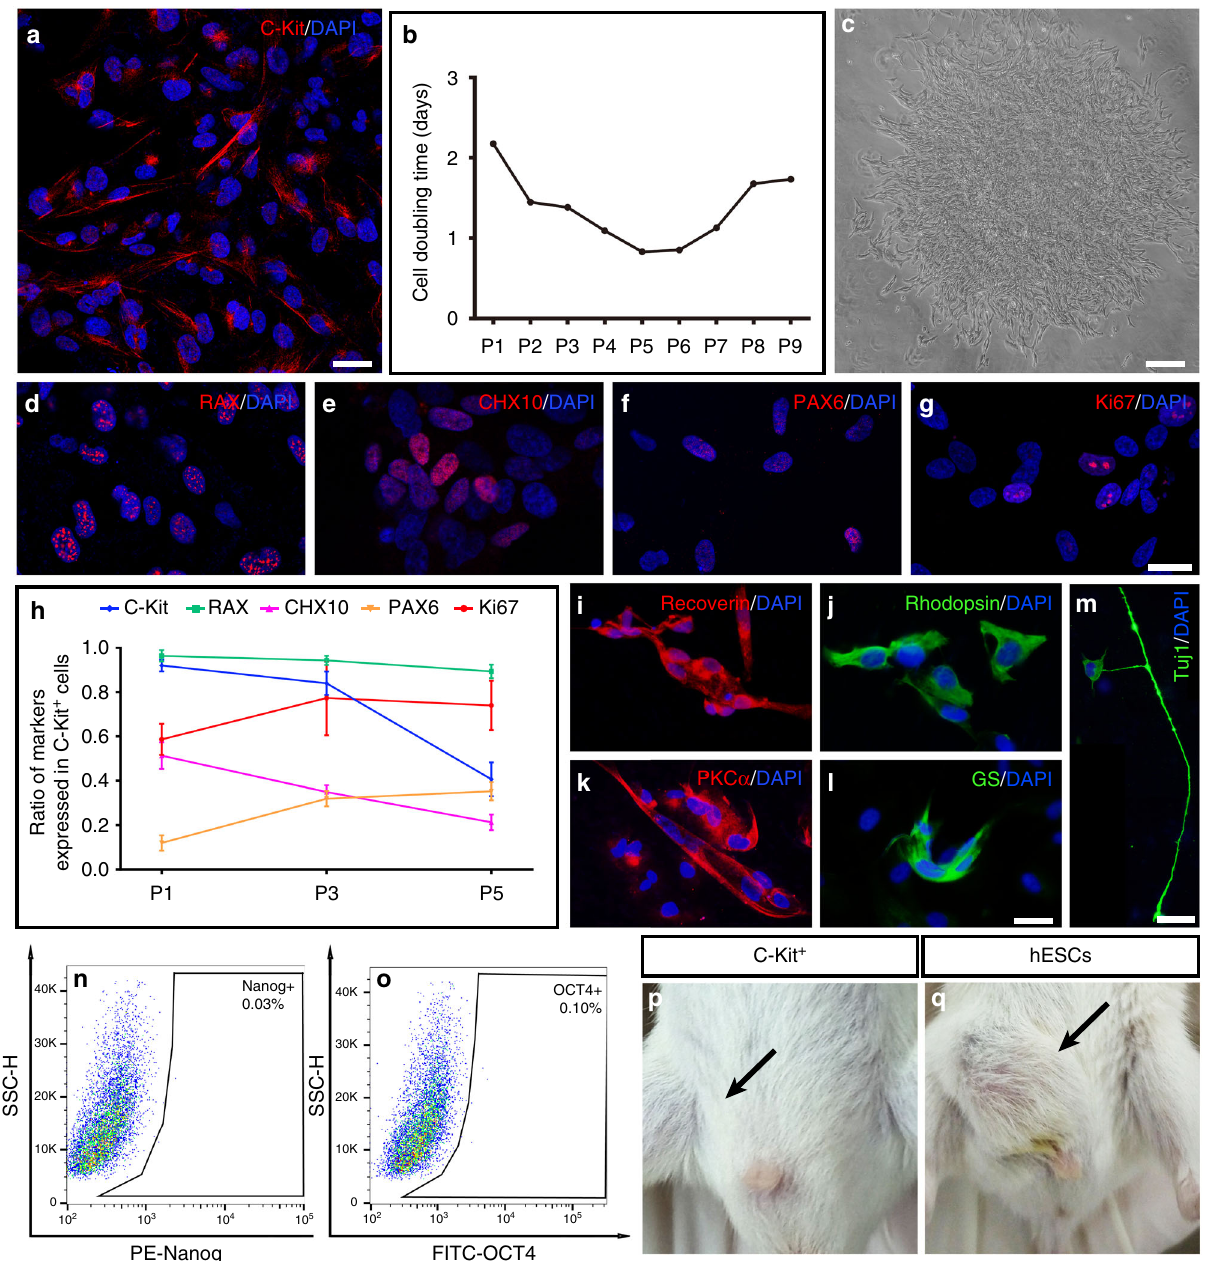
Fig. 3 Characteristics of C-Kit + cells obtained from hEROs. a C-Kit expression in 30-day sorted C-Kit + cells at passage 0 (P0). b Comparison of cell doubling time among C-Kit + cells sorted from 30-day hEROs ( n = 3 independent experiments/group). c Representative putative clone formation by P3 C-Kit + cells at 2 weeks shown through the limited dilution colony-forming ef fi ciency assay. d – h Expression and quantitative analysis of RPC markers and the proliferation marker Ki67 in C-Kit + cells at different passages. ( n = 3 independent experiments/group). i – m Retinal cell differentiation of C-Kit + cells into photoreceptors was visualized by immunostaining for recoverin and rhodopsin. Bipolar cells were identi fi ed by PKC α staining, Müller cells were identi fi ed by GS staining, and retinal ganglion cells were identi fi ed by Tuj1 staining. n , o Flow cytometry analysis of the expression of embryonic markers, including Nanog and OCT4, in P3 C-Kit + cells. ( n = 3 independent experiments). p , q Tumorigenesis test of P3 C-Kit + cells and human embryonic stem cells (hESCs). No tumor formation was detected in the inguinal region 3 months after C-Kit + cell injection into 6 SCID mice (black arrow in p ). After hESCs injection, 4/6 animals displayed tumor formation (black arrow in q ) ( n = 6 animals/group). Data are presented as mean ± SD. Scale bars, 25 μ m ( a , d – g